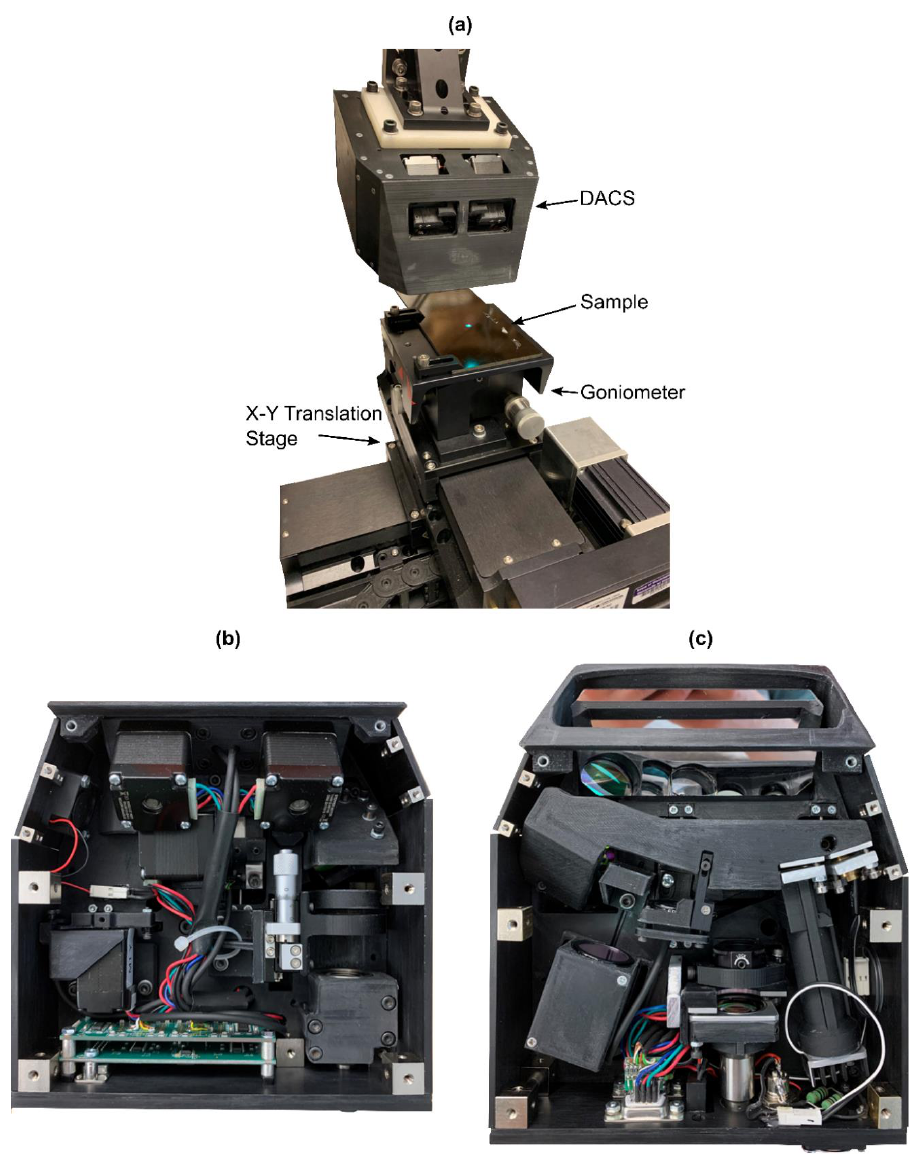
Figure 4. ( a ) DACS experimental setup. ( b ) DACS internal components corresponding to Figure 1d. ( c ) DACS internal components corresponding to Figure 1c.